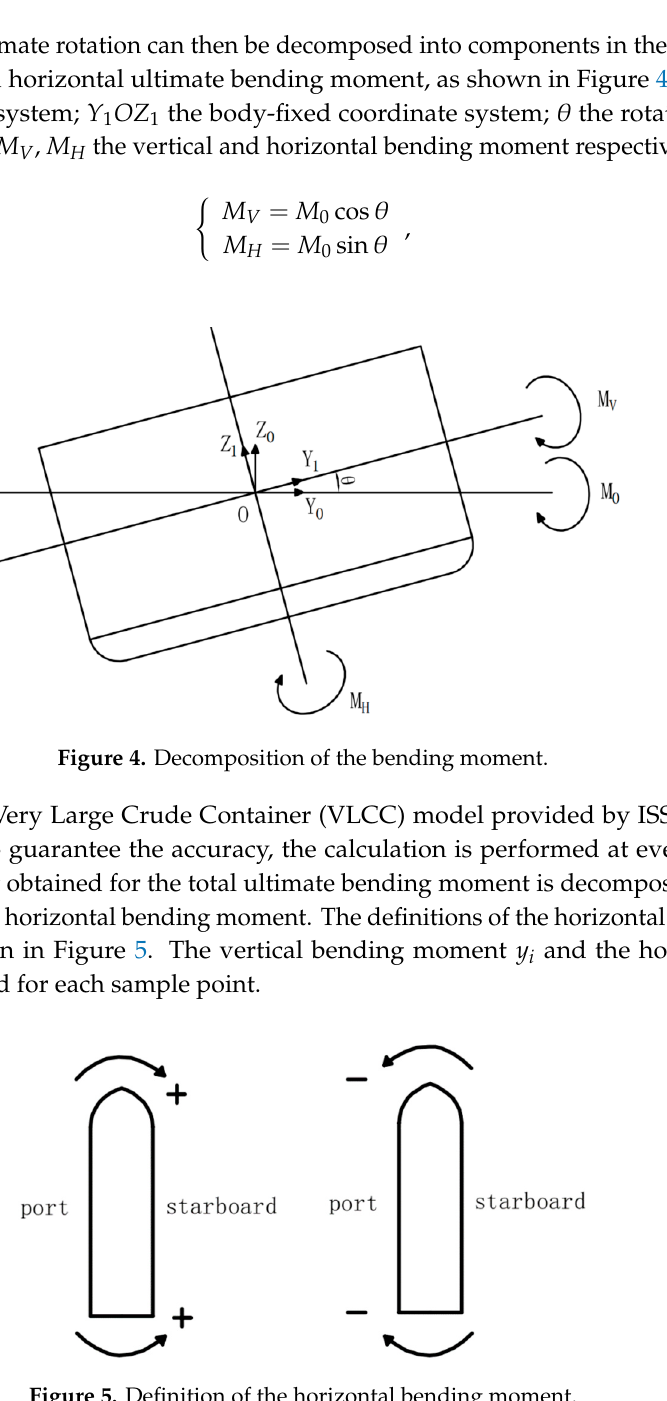
Figure 5. Definition of the horizontal bending moment.